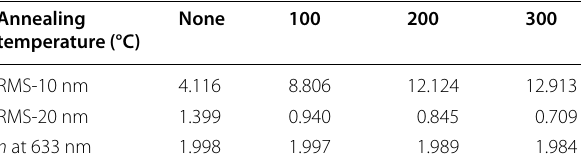
Table 2 Root-mean-square roughness (unit: nm) of